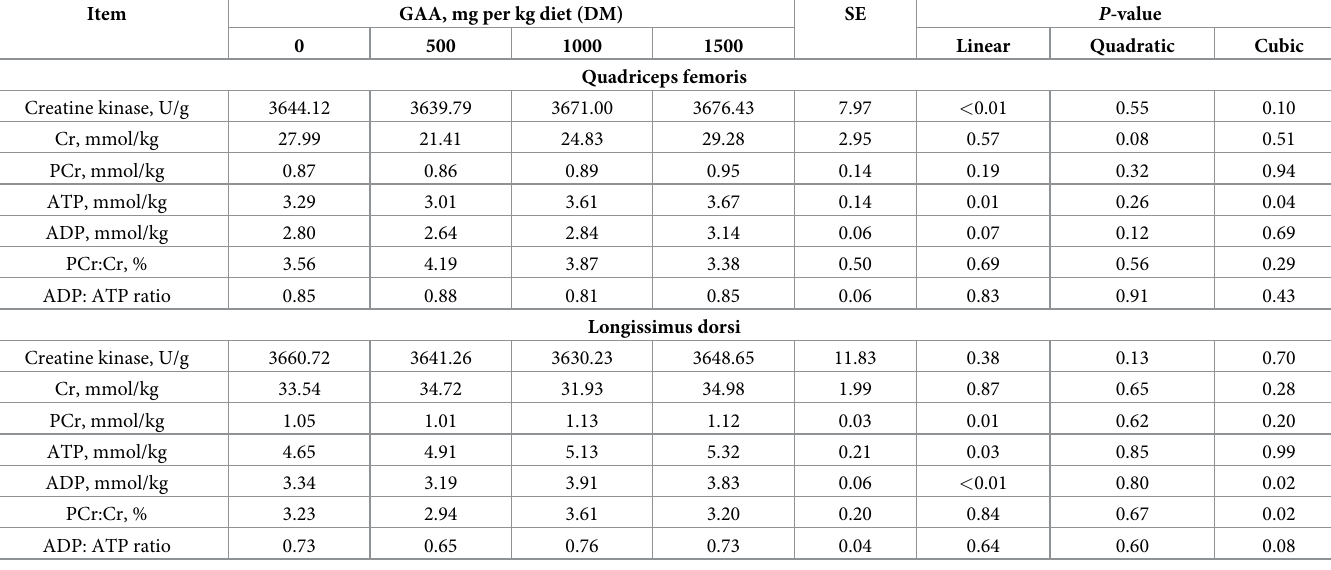
The CK enzyme activity and ATP content in quadriceps muscle increased linearly with increas- ing levels of GAA in the die (Linear, P < 0.05) (Table 5). PCr levels and ADP levels in the longest dorsal muscle increased linearly with increasing levels of GAA in the diet (Linear, P < 0.05). 3.4 Contents of Cr in hepatic vein, and mRNA expression of GAMT in liver With the increase of dietary GAA level, Cr concentration in hepatic vein plasma shows a qua- dratic change (Quadratic, P < 0.05) (Table 6). with the highest Cr concentration in the 500 mg/ kg group and the lowest Cr concentration in the 0 mg/kg group ( P < 0.05). However, the Cr concentration in the liver tissue did not show significant difference ( P > 0.05). Table 5. Effects of supplementation with guanidinoacetic acid on creatine-related metabolism in lambs muscle.